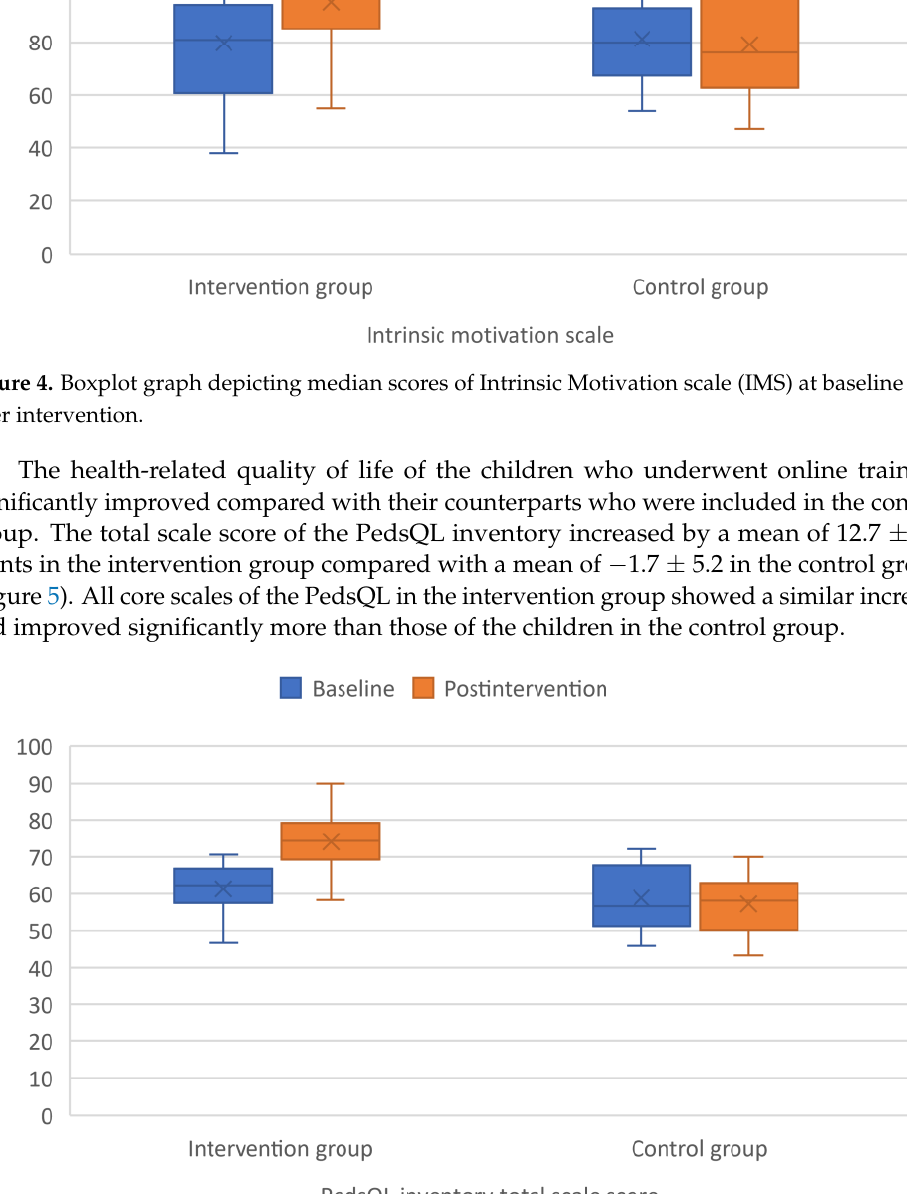
Figure 4. Boxplot graph depicting median scores of Intrinsic Motivation scale (IMS) at baseline and after intervention.